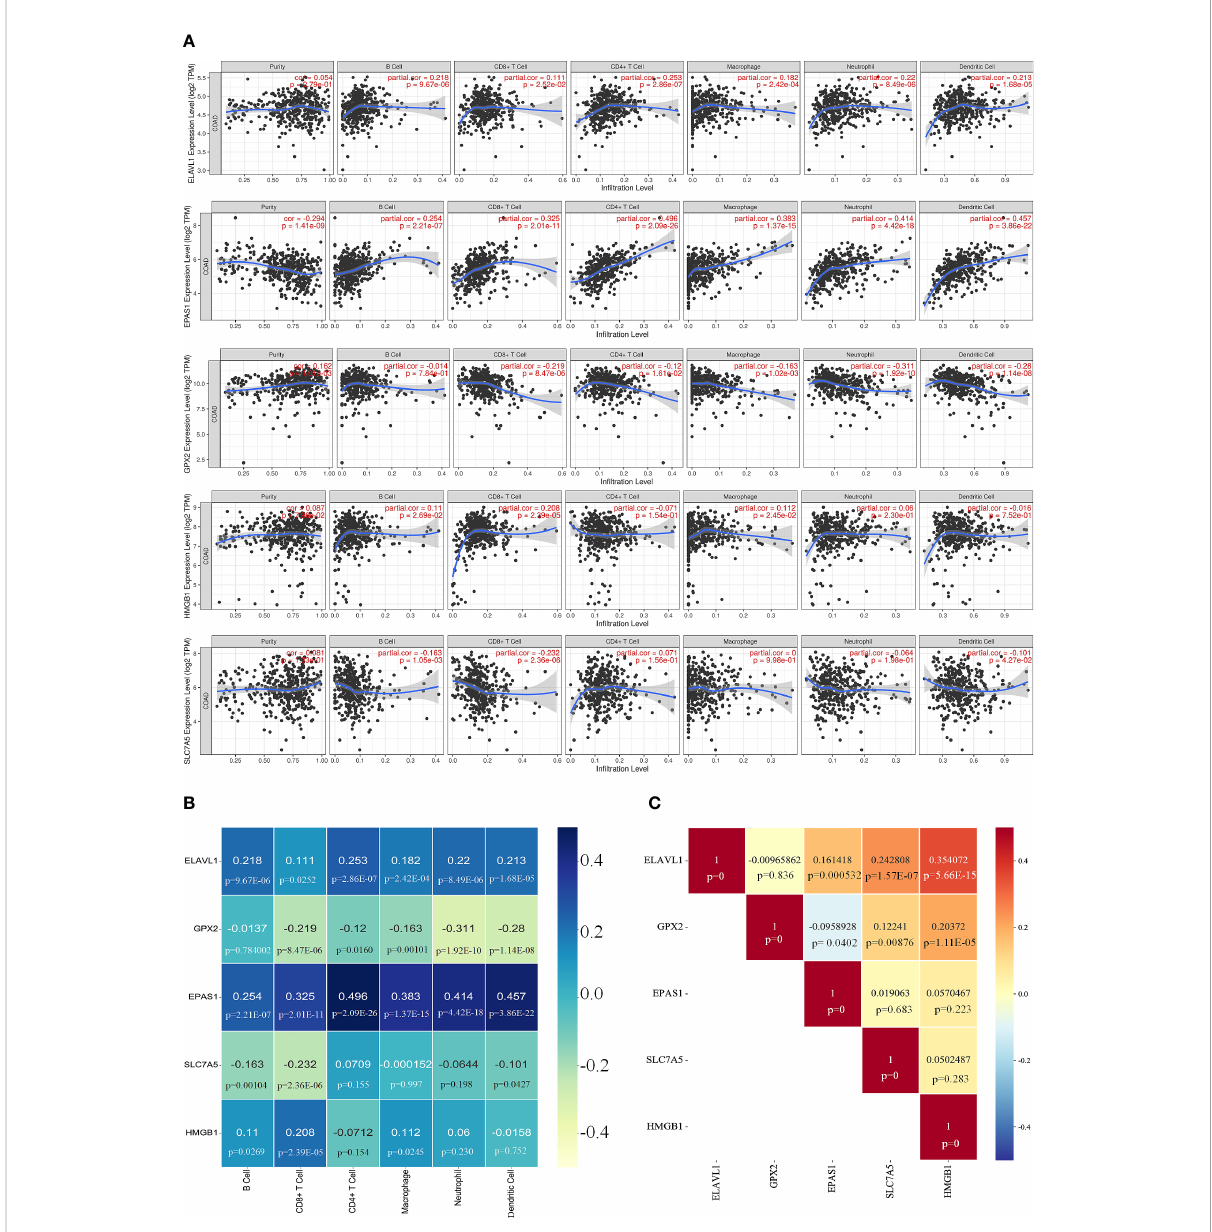
FIGURE 8 Correlation of key genes and immune cells. (A, B) Correlation of fi ve key genes with six immune cell. (C) Signi fi cant relationship between each core